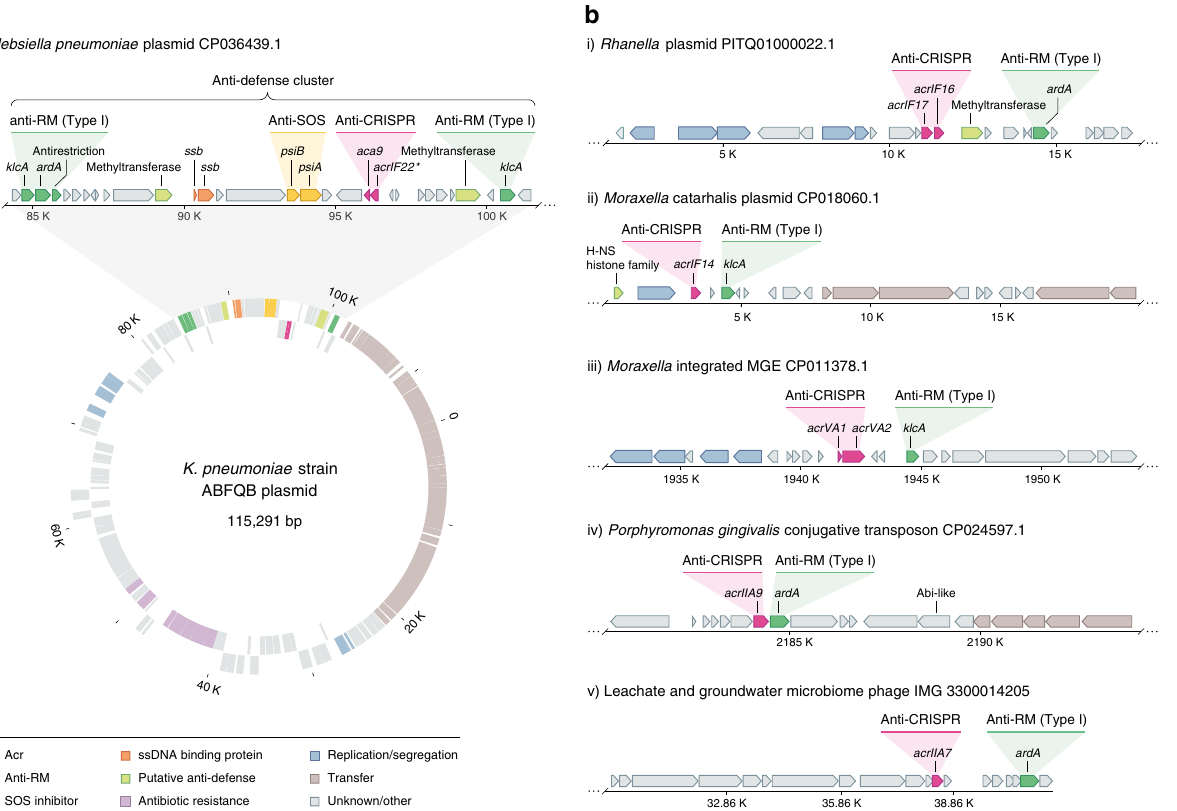
Fig. 6 Acrs cluster with other antagonists of host defense functions. a Genome organization of the Klebsiella pneumoniae ABFQB plasmid unitig_1 (CP036439.1), highlighting the anti-defense cluster region. Genes are colored according to their predicted functions as shown in the key. Coding regions encoded on the plus and minus strands are shown on the outer and inner lanes of the gene map, respectively. b Examples of genomic regions within diverse MGEs where acrs were found in the vicinity of known anti-RM genes and other putative anti-defense determinants. Genes are colored according to the gene key in ( a DNA mimics — analogous to AcrIF2 55 , AcrIF10 56 , AcrIIA2 53,54